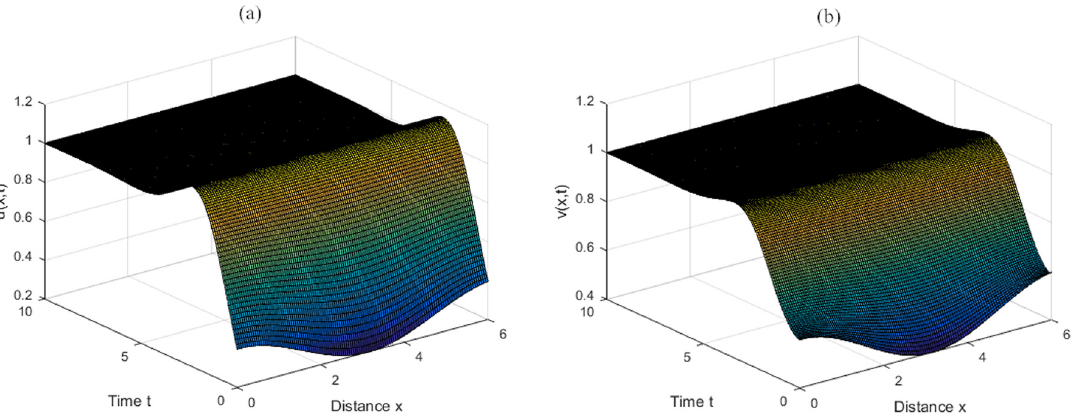
Figure 1: The positive equilibrium E ∗ of system ( 4.42 ) is locally asymptotically stable in the u x t − − space and v x t − − space, respectively.